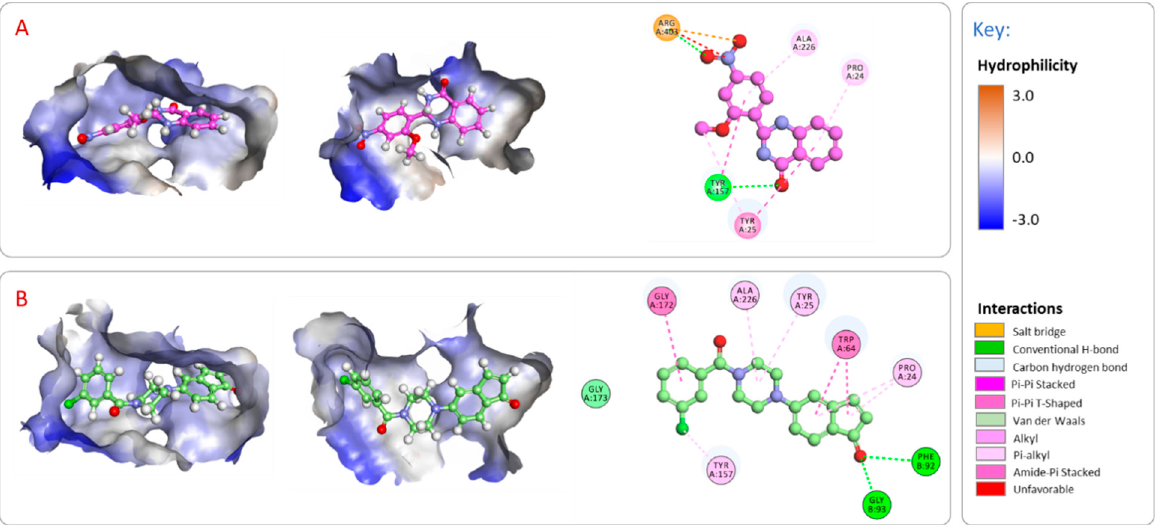
Figure 2. ( A ) The binding mode and binding interactions of compound 3m within the active site of the BioA enzyme compared to that of the co-crystallized ligand (41O, PDB code 4XJO) in ( B ). The left and middle panels show the binding modes of compound 3m and 41O. The active site is shown as a hydrophobic surface. The right panel shows the 2D interaction maps of the two compounds. The interacting amino acid residues are shown as disks and are colored according to the type of their intermolecular interactions with the enzyme.